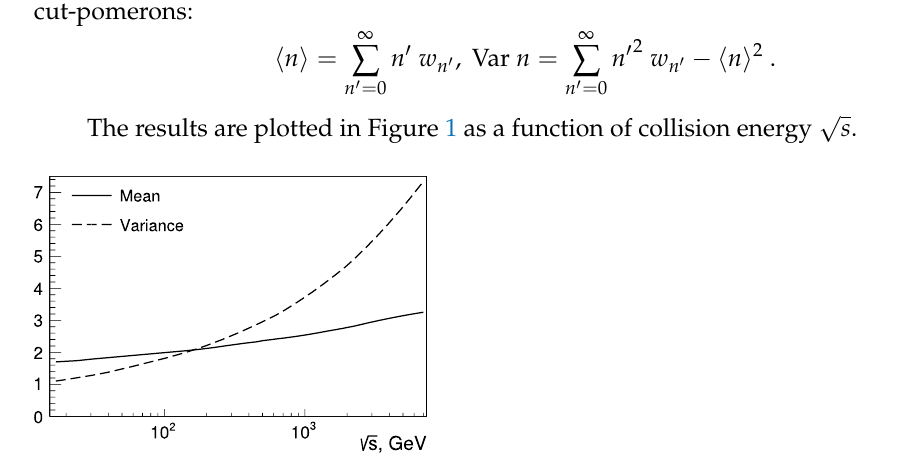
Figure 1. Mean (solid line) and variance (dashed line) of the number of pomerons